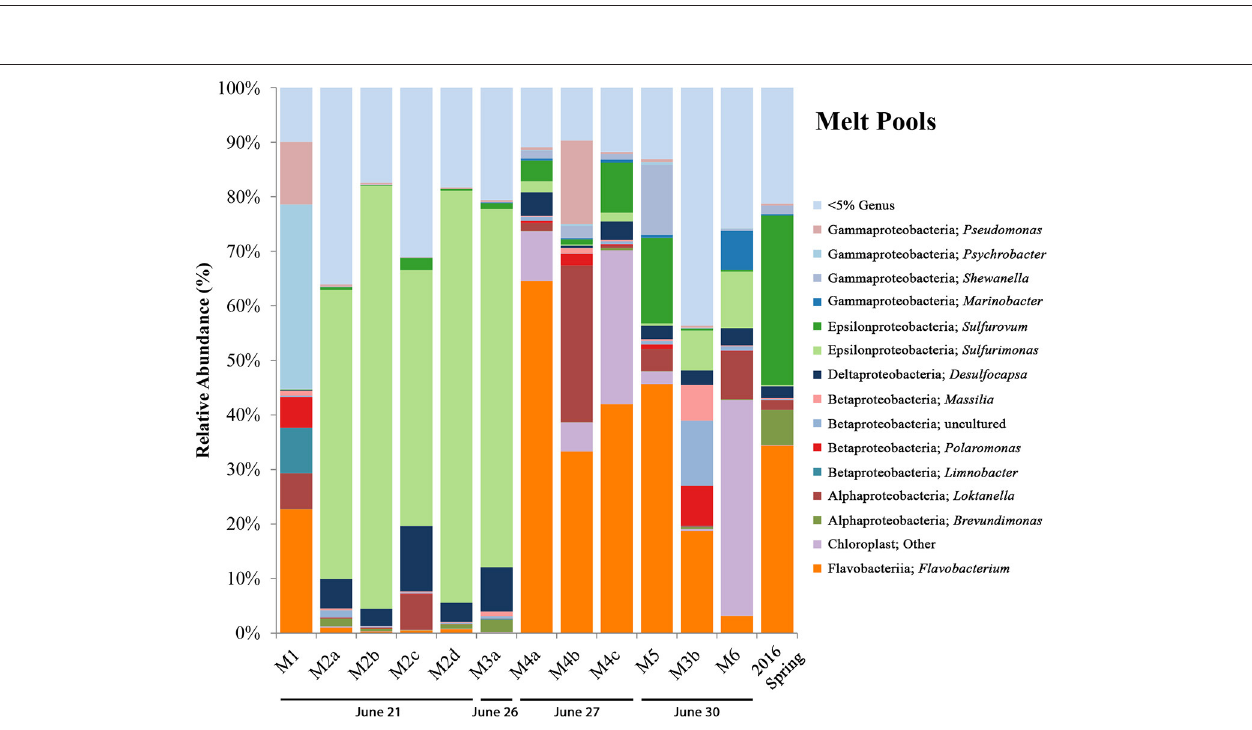
FIGURE 3 | BFP melt pool bar charts. Bar charts show relative abundance of 16S rRNA gene sequencing libraries, where only OTUs representing organisms more than 5% of any given sample are labeled. All other OTUs below 5% relative abundance are grouped together in the category “Genus < 5%.” Labels show Class and subsequent Genus level. Sites are in order of sampling date from left to right. All melt pool sites are within the Sulfidic Aufeis zone. Sites are named such that any replicates are denoted by lowercase letters. Exact locations of all melt pool sites can be seen in Figure S1.